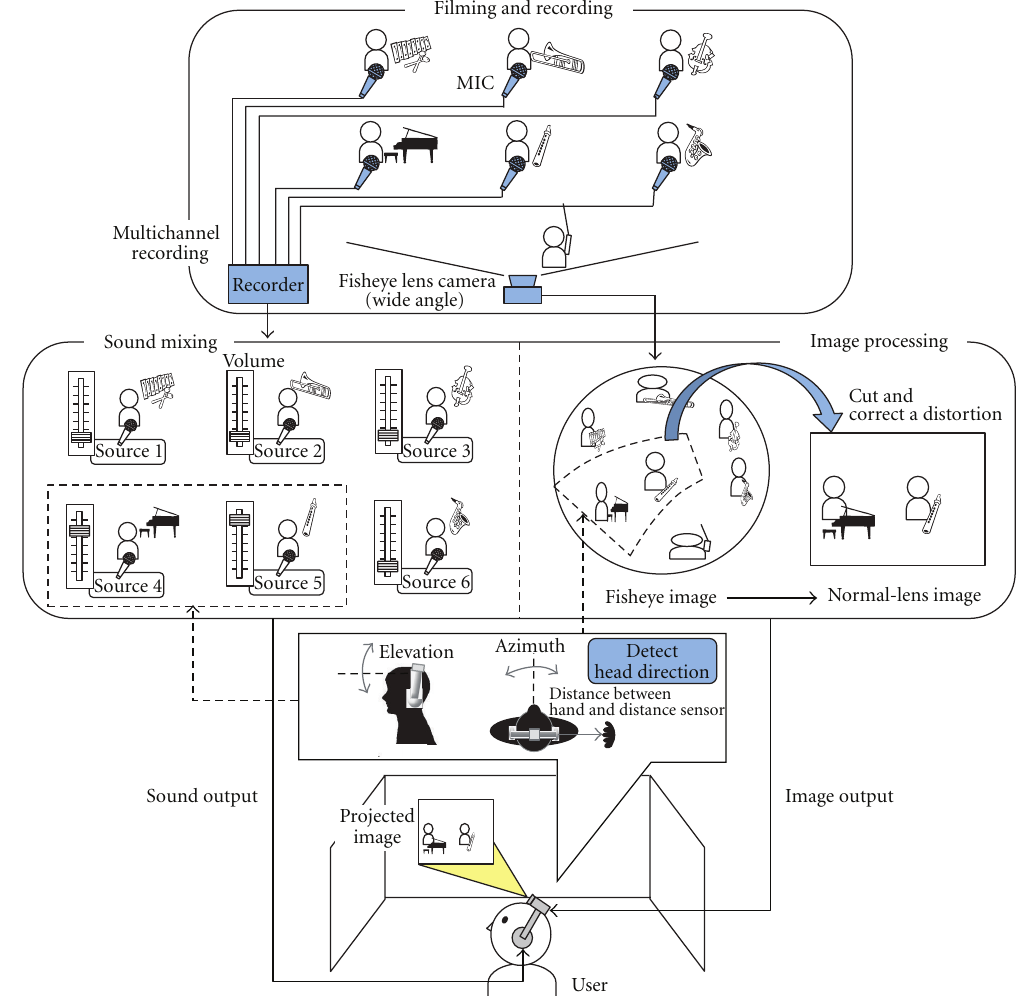
Figure 1: System flow of audiovisual interface.